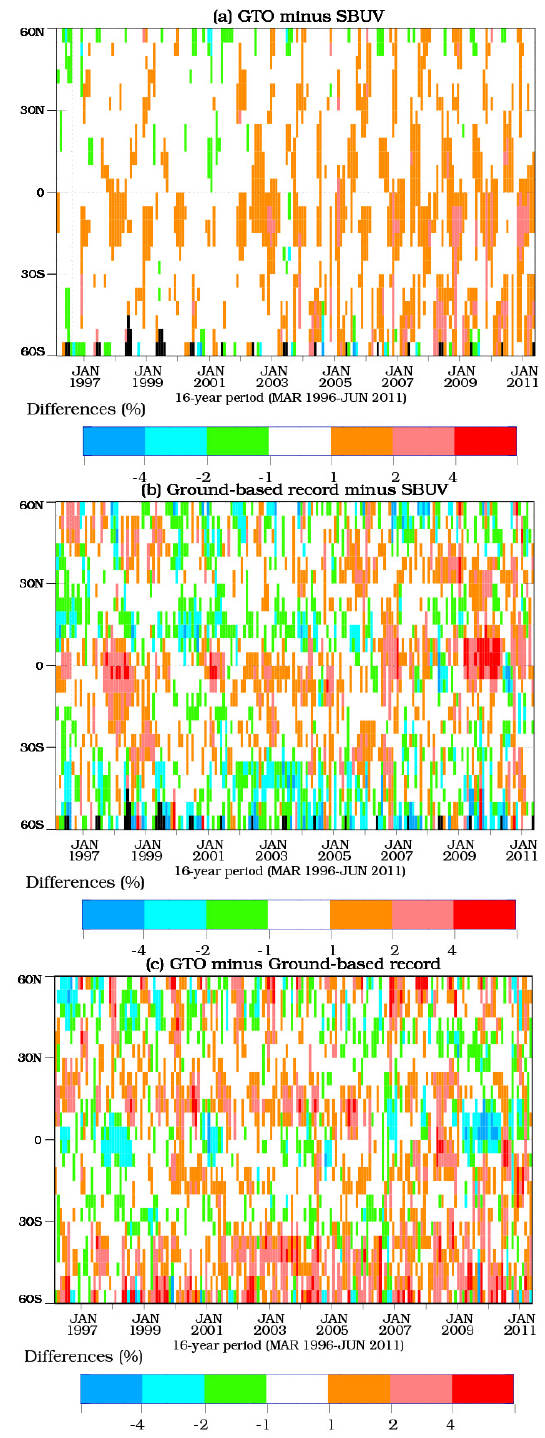
Figure 4. Differences in monthly zonal means (5-degree zones): (a) GTO minus SBUV, (b) ground-based minus SBUV, and (c) GTO minus ground-based. (Black regions represent missing data in SBUV v8.6.)